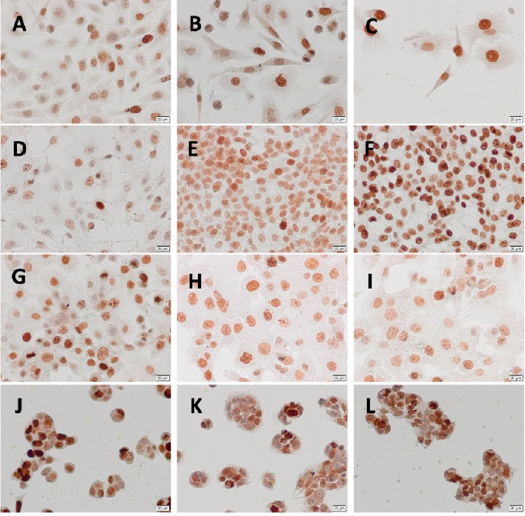
Figure 2. H2AX staining on PC3 ( A – C ), Vero ( D – F ), DU145 ( G – I ) and HT29 ( J – L ) after 48 h incubation with Ru 1 ( A , D , G , J ), Ru 2 ( B , E , H , K ), Ru 3 ( C , F , I , L ) compounds Scale Bars: 20